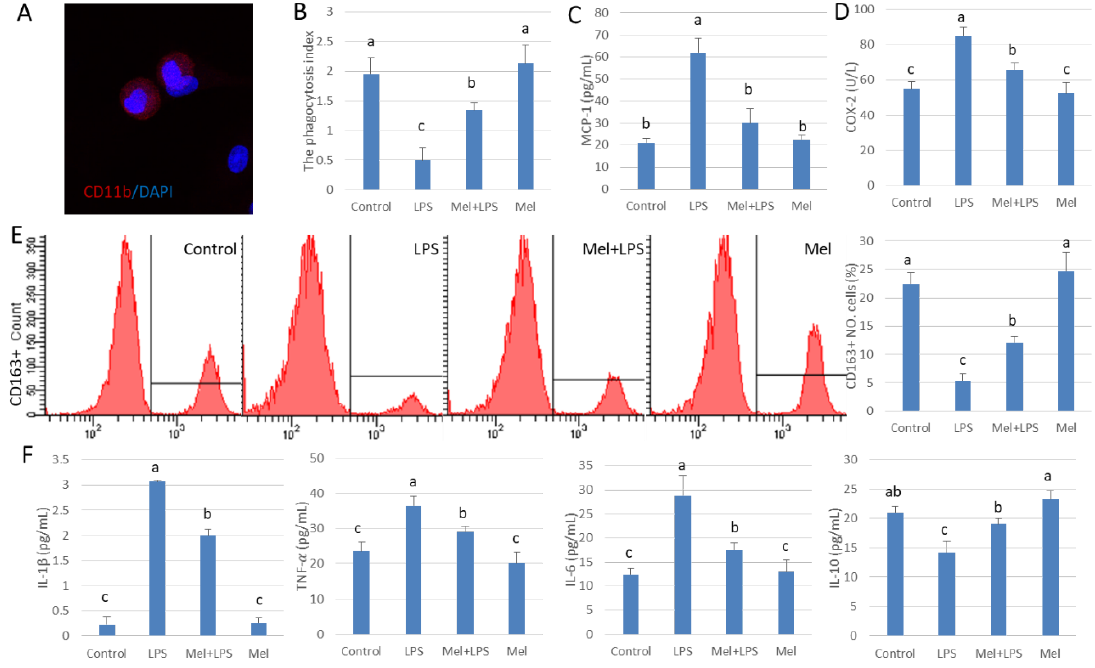
Figure 2. Melatonin improves phagocytosis in LPS-treated testicular macrophages. ( A ) Figure 2. MelatoninimprovesphagocytosisinLPS-treatedtesticularmacrophages. ( A ) Immunofluorescence Immunofluorescence stain in cultured testicular macrophages, CD11b (Red) and DAPI (Blue). ( B ) stain in cultured testicular macrophages, CD11b (Red) and DAPI (Blue). ( B ) Phagocytosis. ( C , D ) ELISA was Phagocytosis. ( C , D ) ELISA was used to detect the expressions of MCP-1 and COX-2. ( E ) Expression used to detect the expressions of MCP-1 and COX-2. ( E ) Expression of CD163 was analyzed by flow of CD163 was analyzed by flow cytometry. ( F ) ELISA detection IL-1β, TNF-α, IL-6 and IL-10 protein cytometry. ( F ) ELISA detection IL-1 β , TNF- α , IL-6 and IL-10 protein expression. Experiments were expression. Experiments were divided into the control group, the LPS infection group, and the divided into the control group, the LPS infection group, and the Mel + LPS and Mel group. Data are Mel+LPS and Mel group. Data are shown as mean ± SEM. Different superscript letters (a–c) in each shown as mean ± SEM. Di ff erent superscript letters (a–c) in each column representative statistically column representative statistically significant differences ( p < 0.05). significant di ff erences ( p <